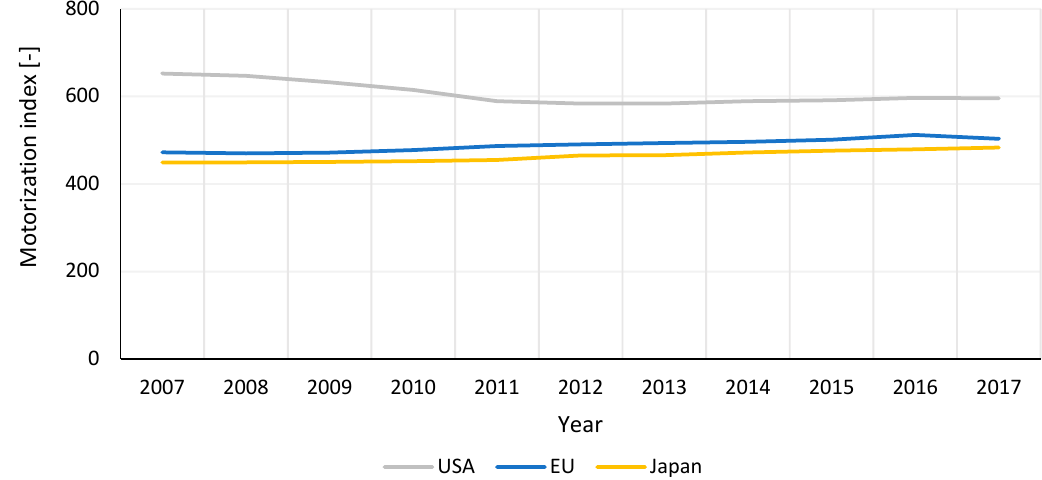
Figure 2. Motorization indexes in the United States, European Union and Japan in 2007–2017.